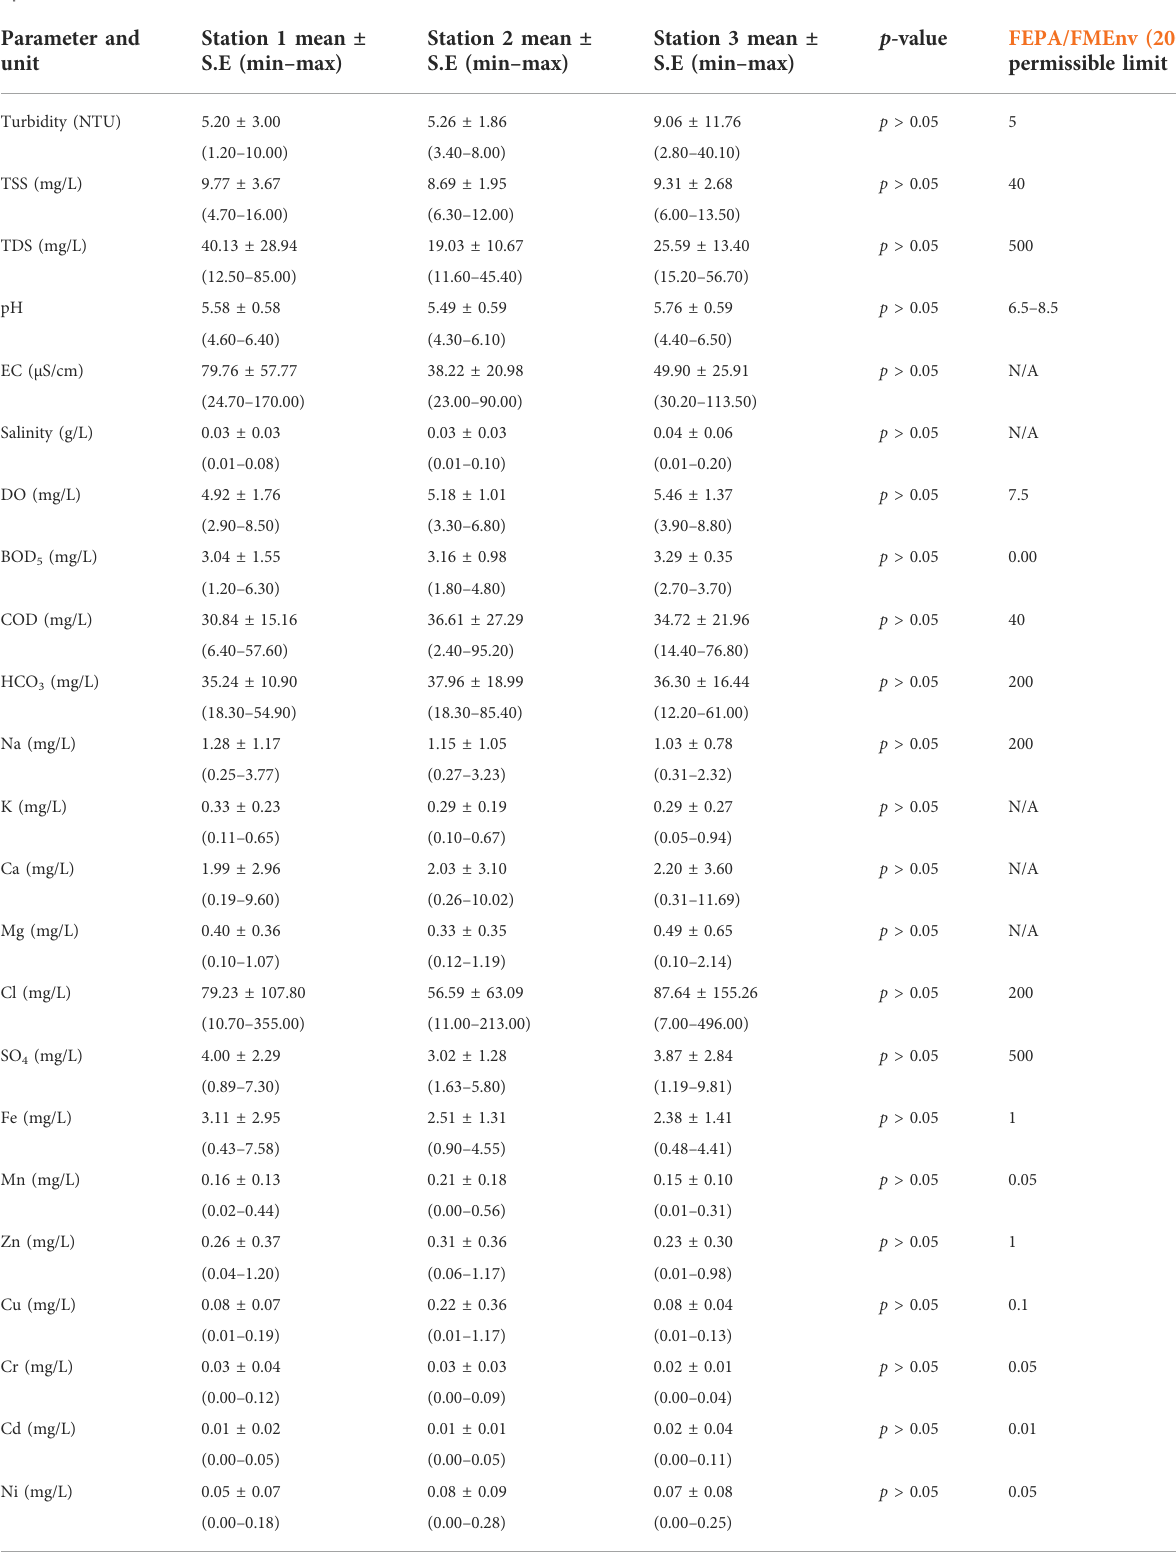
TABLE 1 Summary of the physicochemical parameters in the three designated stations at the Orogodo River, Agbor, Delta State, for the period of April – December 2011. Parameter and